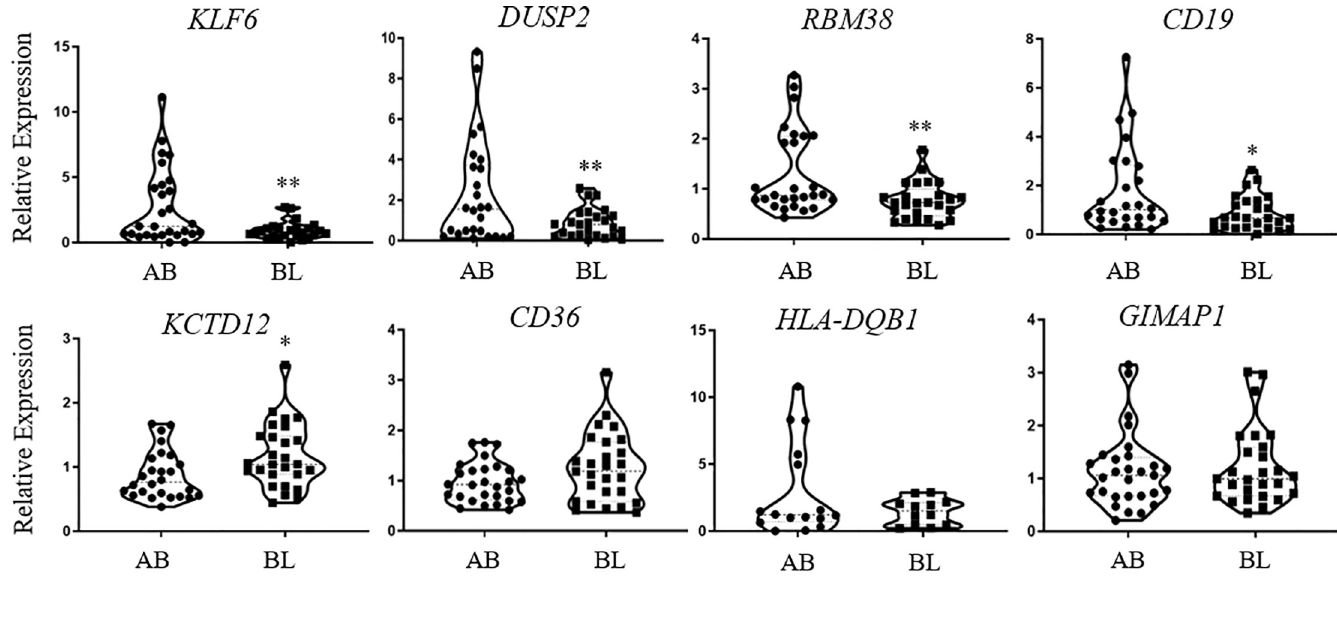
Fig 5. mRNA validation in African American males living in poverty. 11 mRNAs identified from our microarray analysis were validated using real-time quantitative PCR in African American males living above (AB) or below (BL) poverty. Genes were quantified using mRNA-specific primers and outliers were excluded. All genes were normalized to the combined average of ACTB and GAPDH . Violin plots of the eleven genes compared BL (n = 27) vs AB (n = 29). � P < 0.05, �� P < 0.01; Student’s t-test.